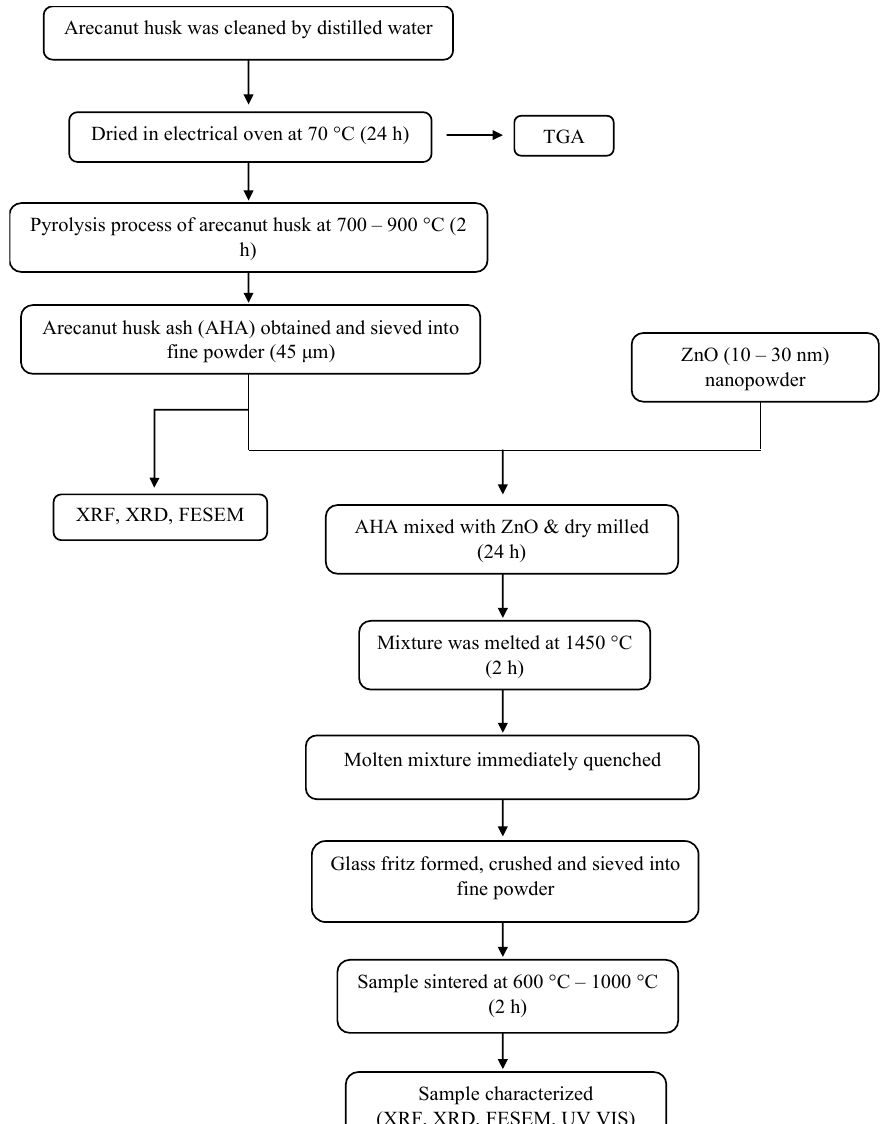
Figure 2. The methodology of producing zinc silicate from waste arecanut husk.